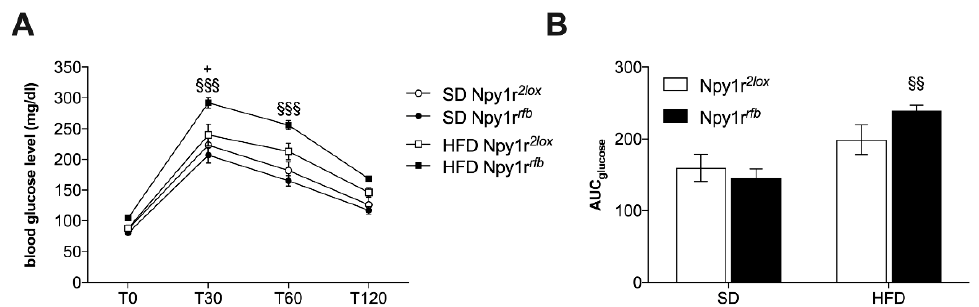
Figure 4. ( A ) Glucose tolerance test and ( B ) area under the curve (AUC) of Npy1r 2lox and Npy1r rfb male mice 21 days after SD or HFD exposure. Data are presented as mean ± SEM. ( A ) + p = 0.067 versus Npy1r 2lox on HFD, §§§ p < 0.001 versus Npy1r rfb on SD; ( B ) : §§ p < 0.01 versus Npy1r rfb on SD.